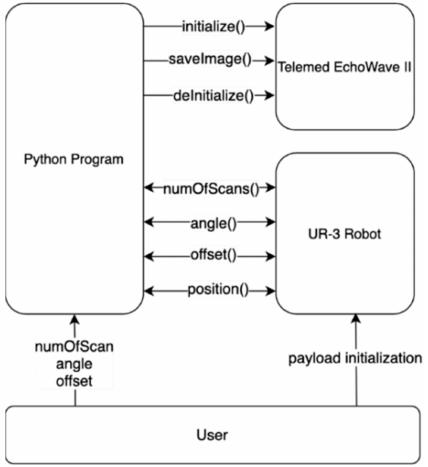
Figure 4. UR-3 robot and EchoWave II control software communication